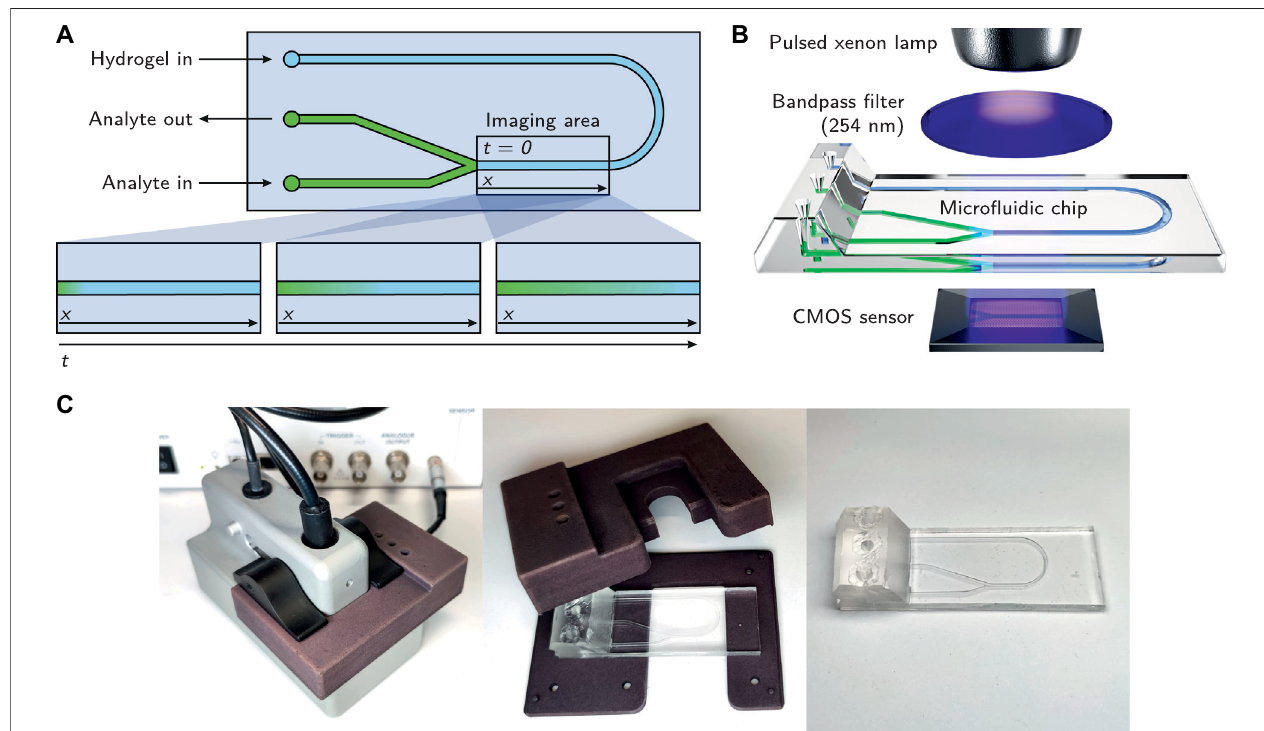
FIGURE 2 | (A) Schematic of the micro fl uidic chip. The imaging area being observed by the ActiPix ™ is roughly indicated with a rectangle. The bottom part of the sub fi gure shows the observed diffusion of the analyte through the hydrogel over time. (B) Overview of the essential components of the employed setup. The illustration demonstrates the integration of the micro fl uidic chip within the Actipix ™ imaging system. Absorbance area measurements are generated by guiding light from a pulsed xenonlampthrougha254 nmbandpass fi lterandthemicro fl uidicchipbeforebeingdetected byaCMOSsensor. (C) Photographsofthemicro fl uidicchipwiththe casing.